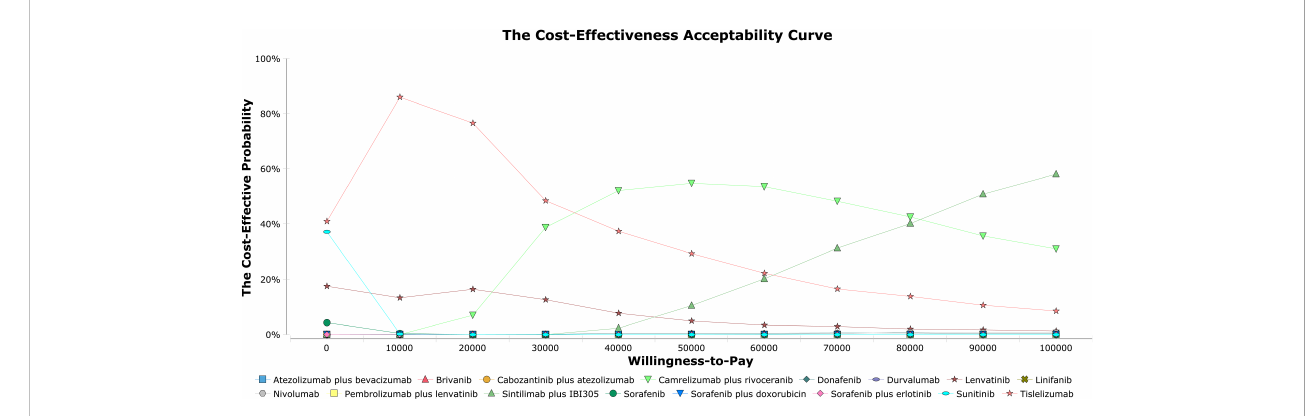
FIGURE 4 The cost-effectiveness acceptability